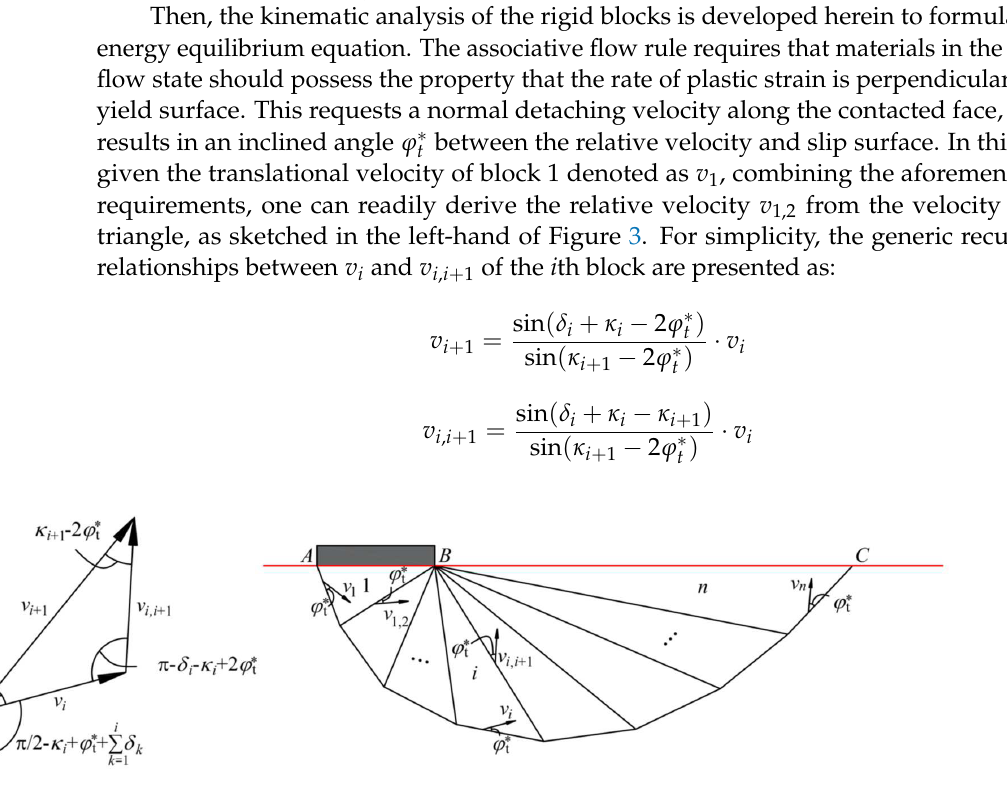
Figure 3. Velocity vector diagram of failure blocks.